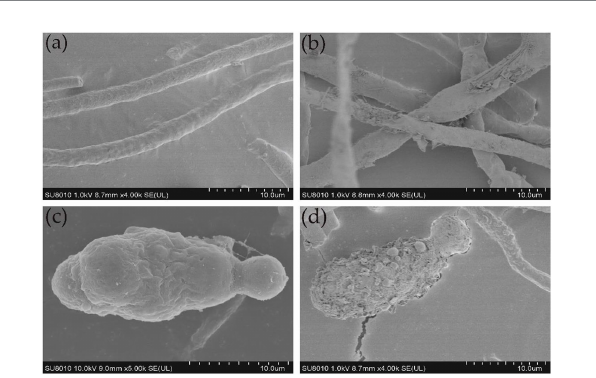
FIGURE 8 Ultrastructural changes in the hyphae and conidia of A. alternata . (A) Control group; healthy hyphae. (B) Effect of 10 μ L of 300 μ g/mL of LPs on hyphae. (C) Control group; healthy conidia. (D) Effect of 10 μ L of 300 μ g/ml of LPs on conidia.